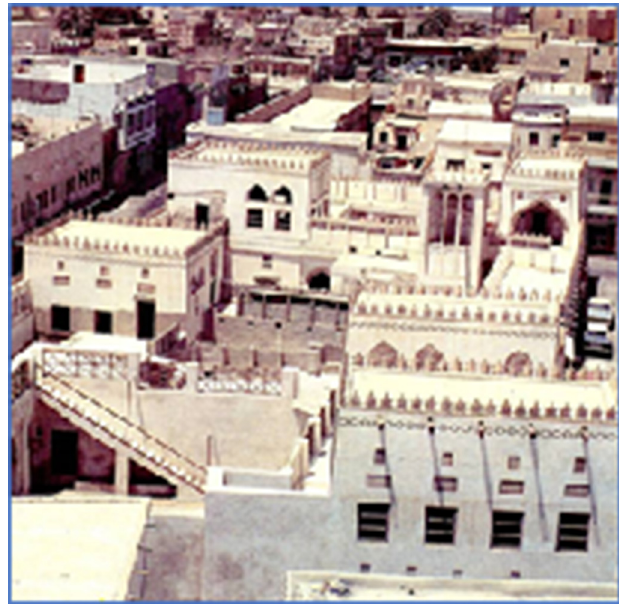
Fig. 2. Compact buildings in a traditional town increase the shade and wind movement on